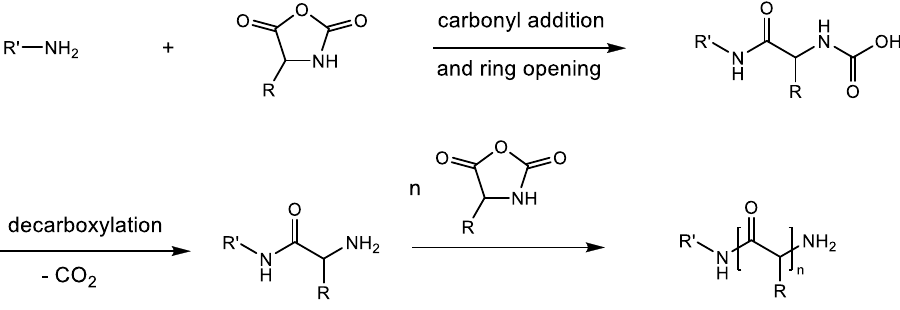
Figure 3. Mechanism of primary amines-initiated ROP of NCAs.